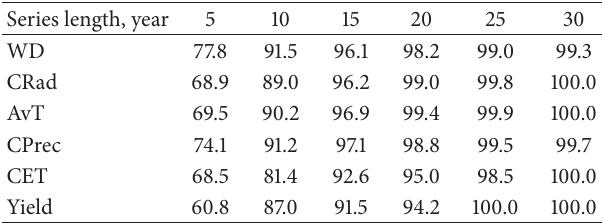
Table 2: Acceptability indices for the investigated monthly climatic variables as well as for the investigated crop model